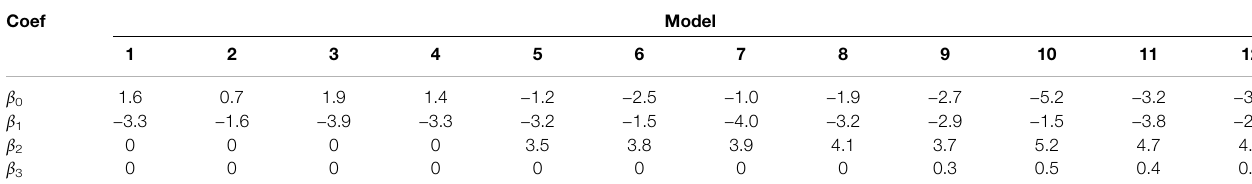
TABLE 9 | Twelve logistic regression models: z (cid:2) β 0 + β 1 rank + β 2 charmatch + β 3 log (1 + freq ). Coef